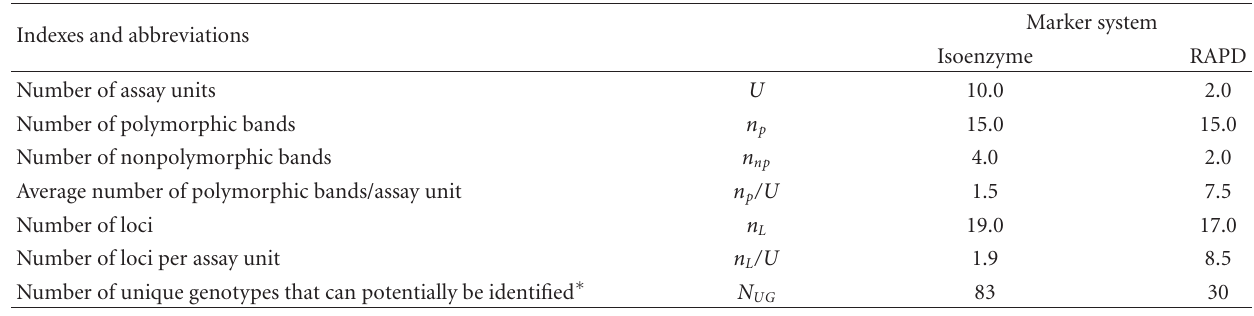
Table 5: Polymorphism levels and comparison of discriminating capacity of codominant (isoenzyme) and dominant (RAPD) markers.